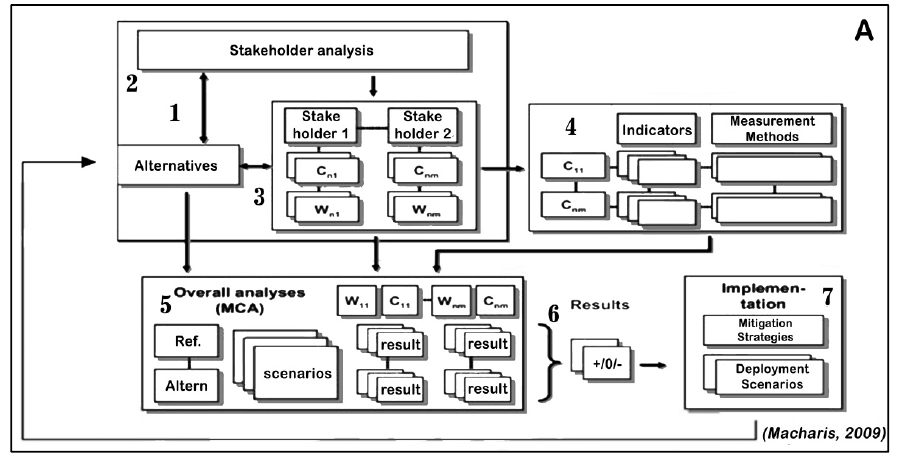
Figure 2. Multi-actor multi-criteria analysis (method A)